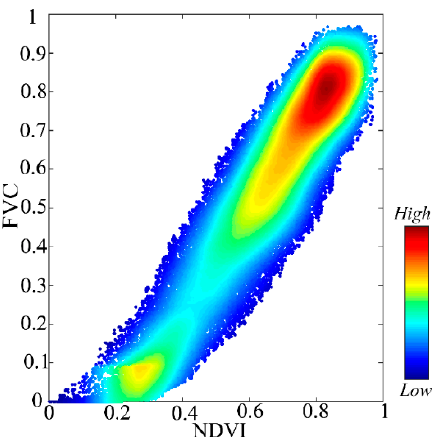
Figure 6. Density scatter plots of the NDVI from VIIRS data and the Global LAnd Surface Satellite (GLASS) FVC values for the refined training samples.